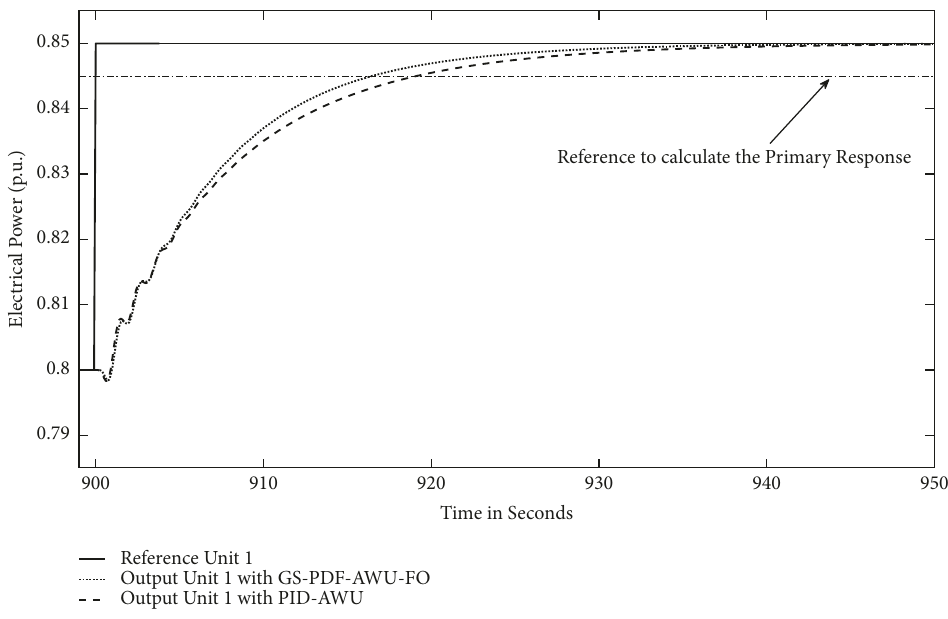
Figure 13: PID and GS-PDF-FO step responses, both with antiwindup, one operational unit, and h=0.9.